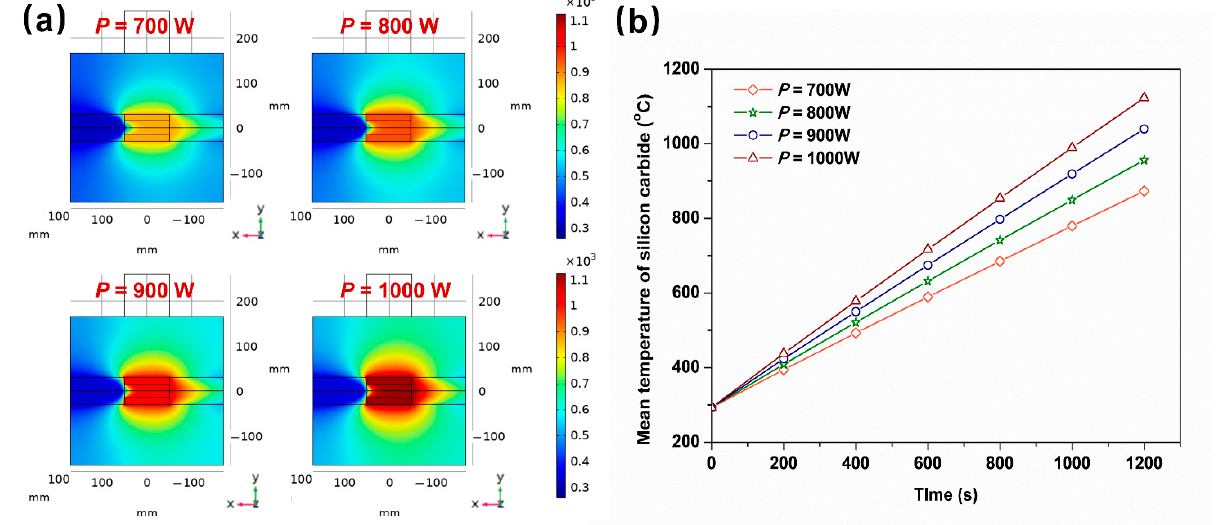
Figure 6. Effect of microwave power on the simulated thermal fields (the temperature unit: K; x–y plane, z = 0; z i = 5 mm; l SiC = 100 mm; v = 0.02 m/s): ( a ) variation of the thermal fields with different microwave power; and ( b ) the heating rate of silicon carbide under microwave irradiation with different microwave power.